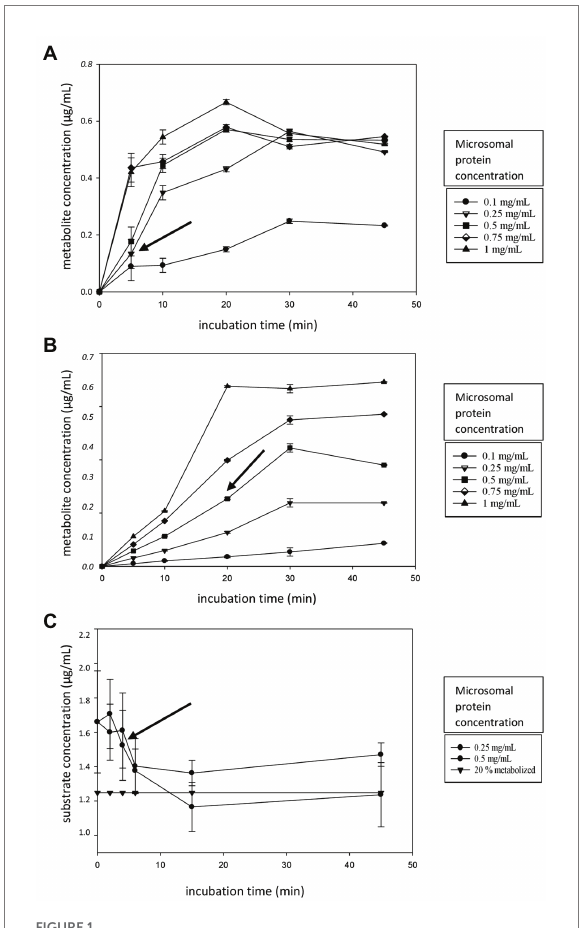
FIGURE 1 (A–C) Linearity experiment figures. (A) The metabolite formation of alpha-hydroxy-midazolam ( α -OH-MDZ, A ) and acetaminophen (B) over time (0–45 min) for different microsomal protein concentrations (0.10–1.0 mg/ml). (C) The AFB1 depletion over time (0–45 min) for different microsomal protein concentrations (0.25–0.50 mg/ml). The horizontal curve (black triangles) represents the 20% metabolite formation threshold. Incubations were performed in triplicate, error bars are displayed. The black arrow indicates the chosen microsomal protein concentration and incubation